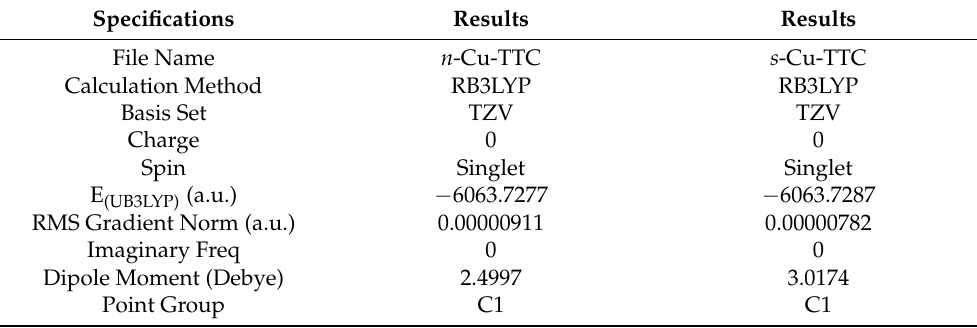
Figure 8. Optimized structures of ( a ) n -Cu-TTC and ( b ) s -Cu-TTC. The Gaussian calculations summaries for both tautomeric structures are compared in Table 2. Table 2. Gaussian calculations summary.